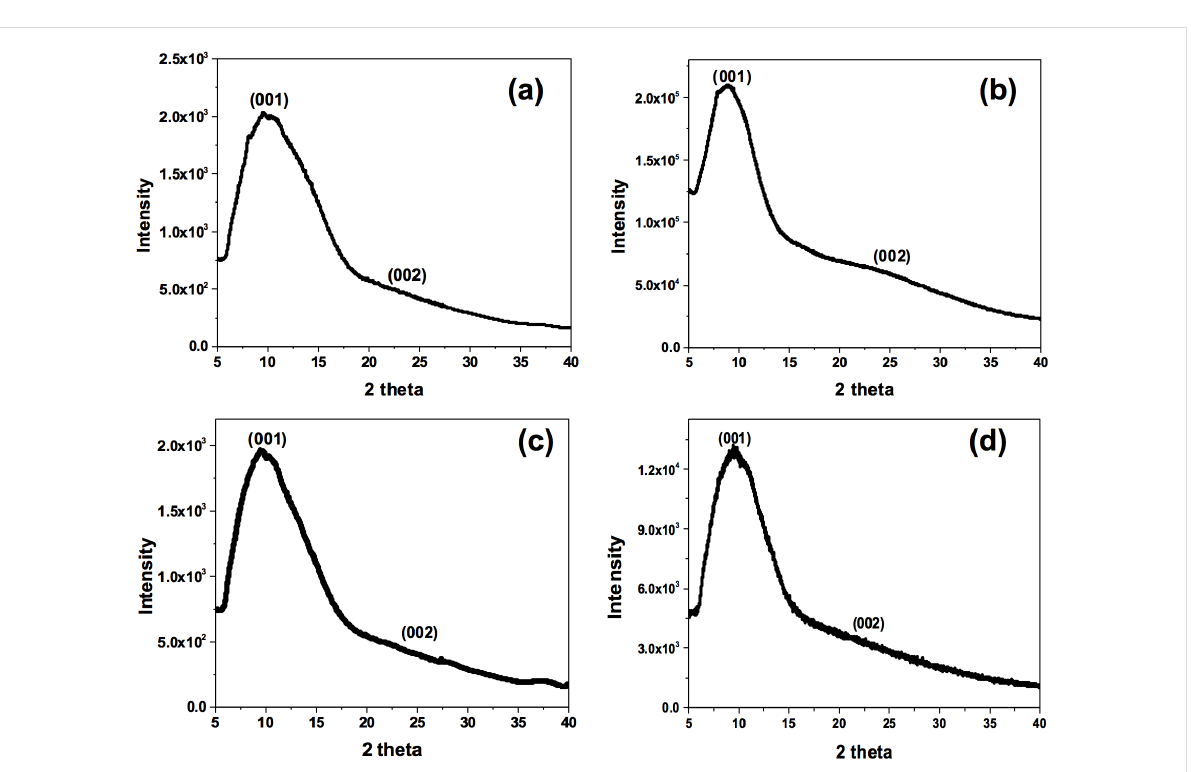
Figure 5: XRD pattern of (a) cinnamon C-dots, (b) red chilli C-dots, (c) turmeric C-dots and (d) black pepper